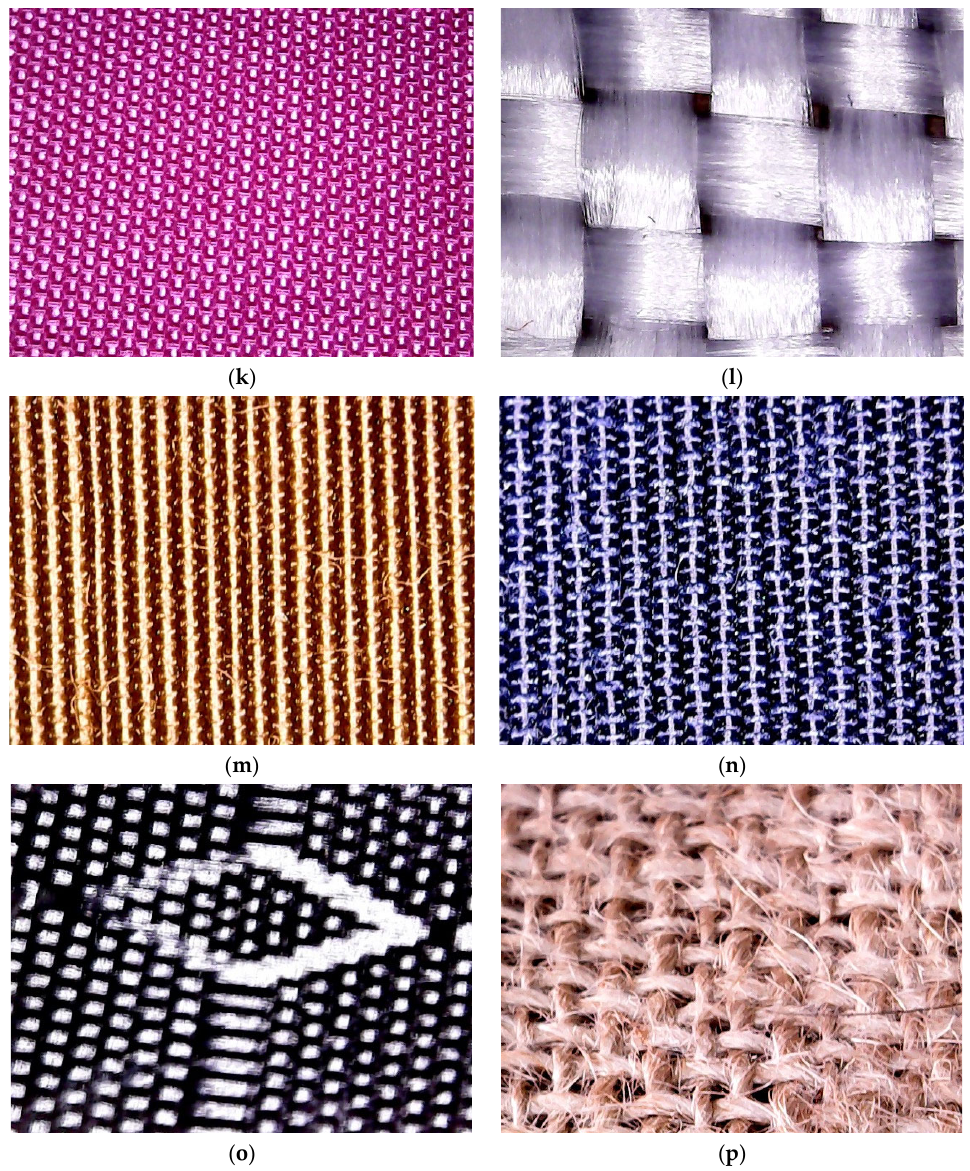
Figure 1. Pictures of selected textile fabrics (horizontal direction shows the warp direction and vertical direction represents the weft direction ( a ) TF1 ( b ) TF2 ( c ) TF3 ( d ) TF4 ( e ) TF5 ( f ) TF6 ( g ) TF7 ( h ) TF8 ( i ) TF9 ( j ) TF10 ( k ) TF11 ( l ) TF12 ( m ) TF13 ( n ) TF14 ( o ) TF15 ( p ) Table 3. Mortar mixture proportion for casting of TRM specimens.